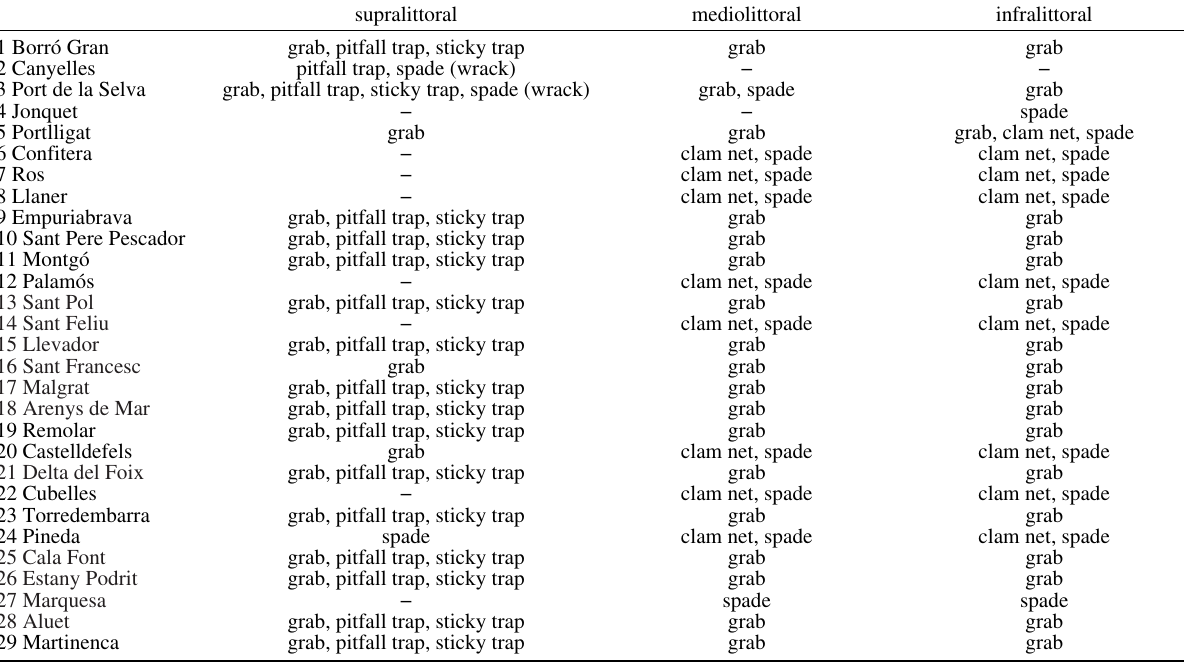
Table 1. – The different methods employed at each site to sample the three littoral levels.